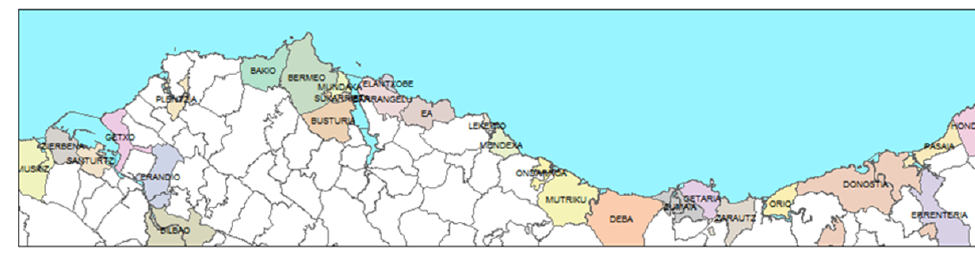
Figure 6. Location of affected